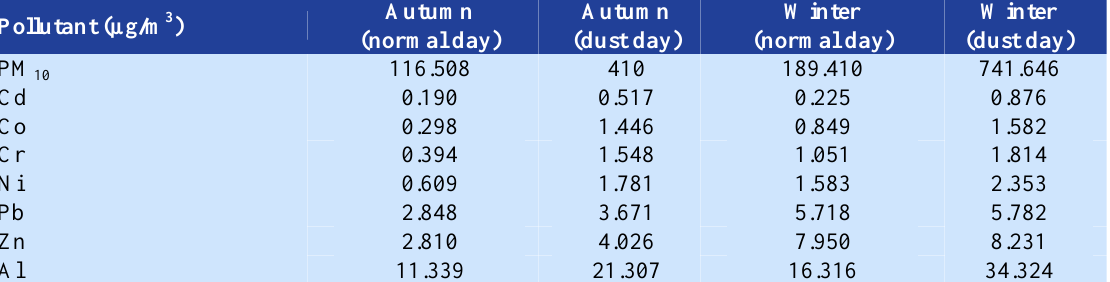
Figure 1. Location of the study area and sampling station, showing the nearby sources of dust storms Table 1. The mean concentrations of PM 10 and the associated heavy metals in the ambient air of Ahvaz, Iran during dusty and normal days in the two